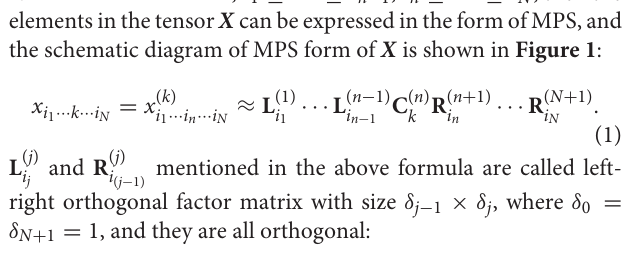
TABLE 3 | Computation times of different algorithms.